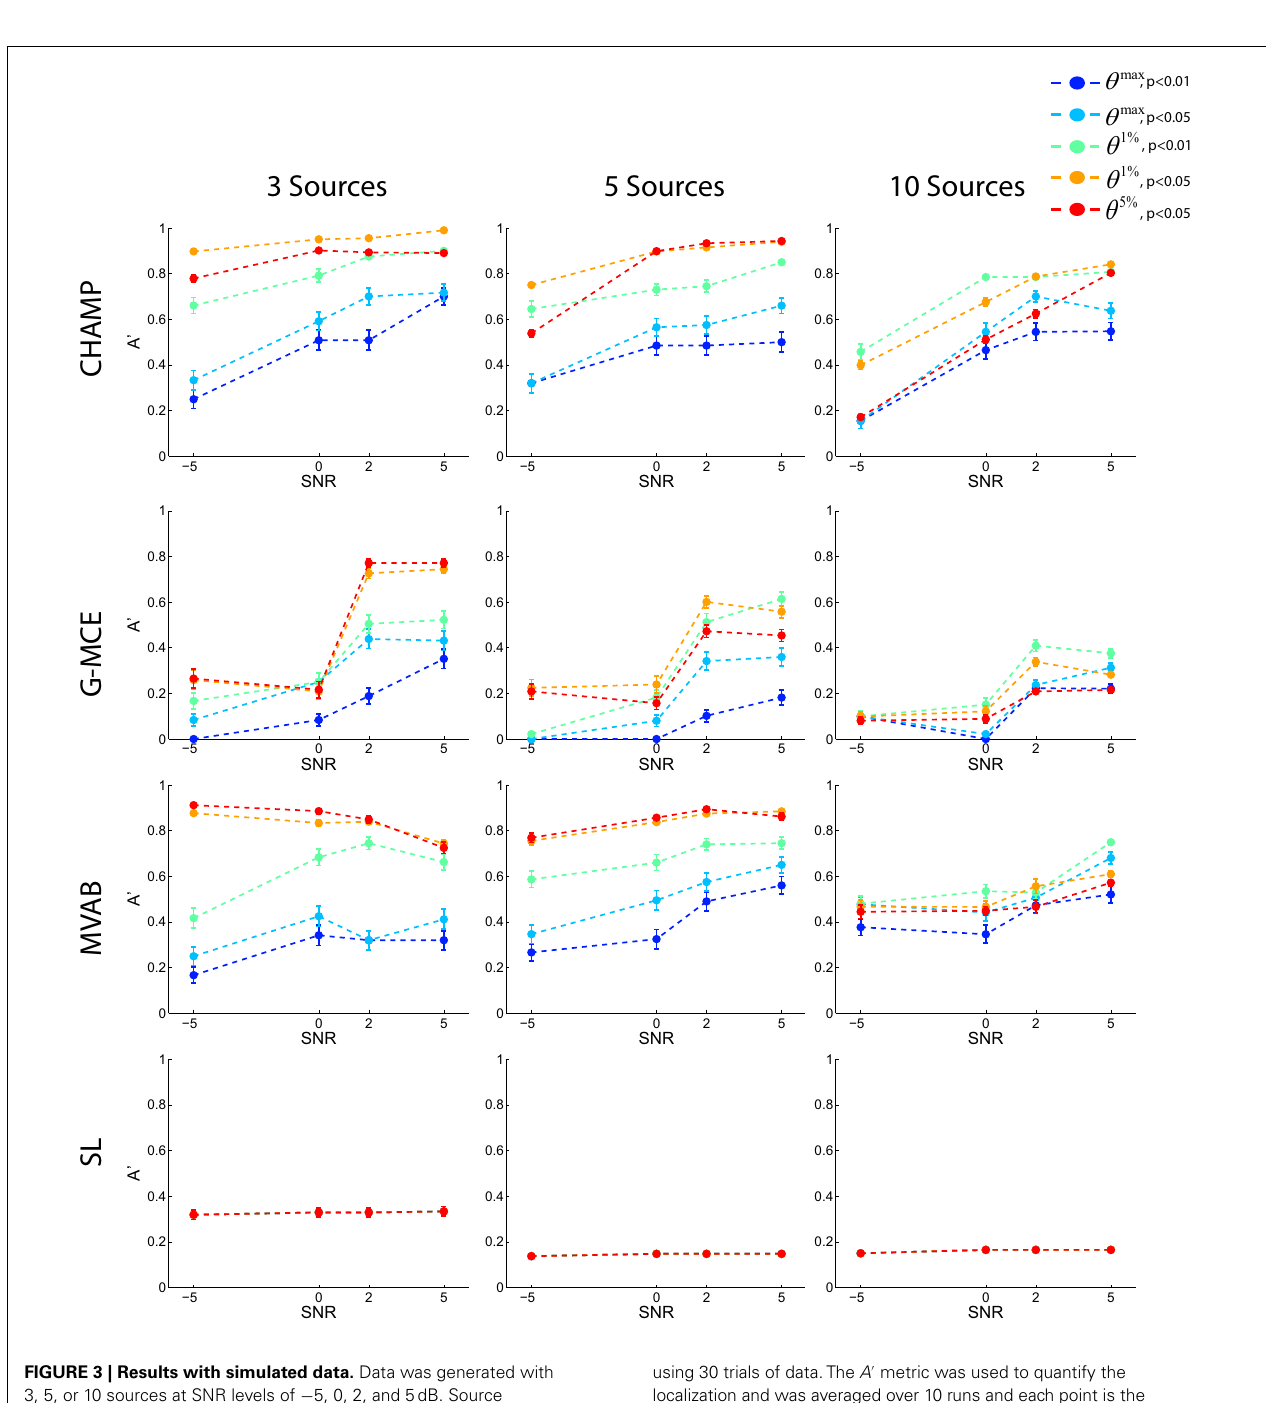
FIGURE 3 | Results with simulated data. Data was generated with 3, 5, or 10 sources at SNR levels of − 5, 0, 2, and 5dB. Source localization was performed with CHAMP, G-MCE, MVAB, and SL